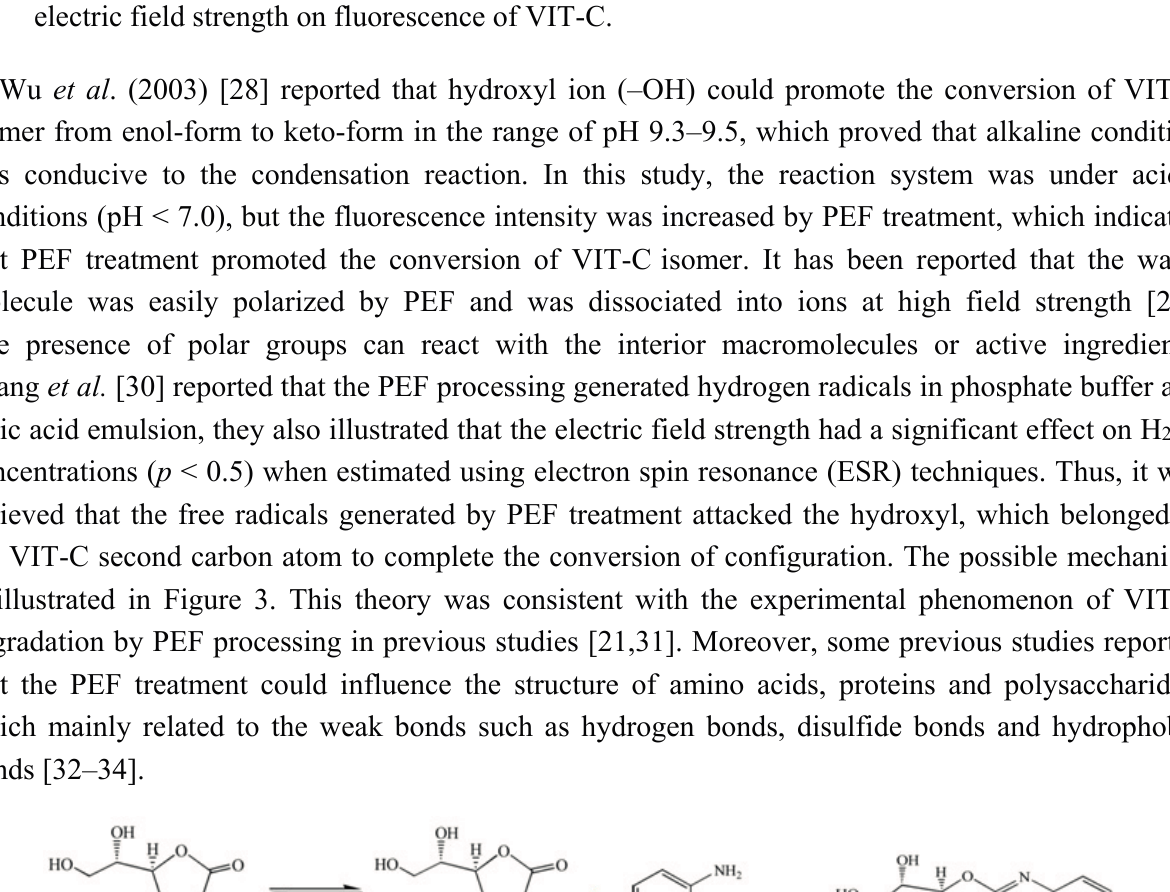
Figure 2. The effect of different pulsed electric fields (PEF) treatment time at 35 kV/cm electric field strength on fluorescence of VIT-C.